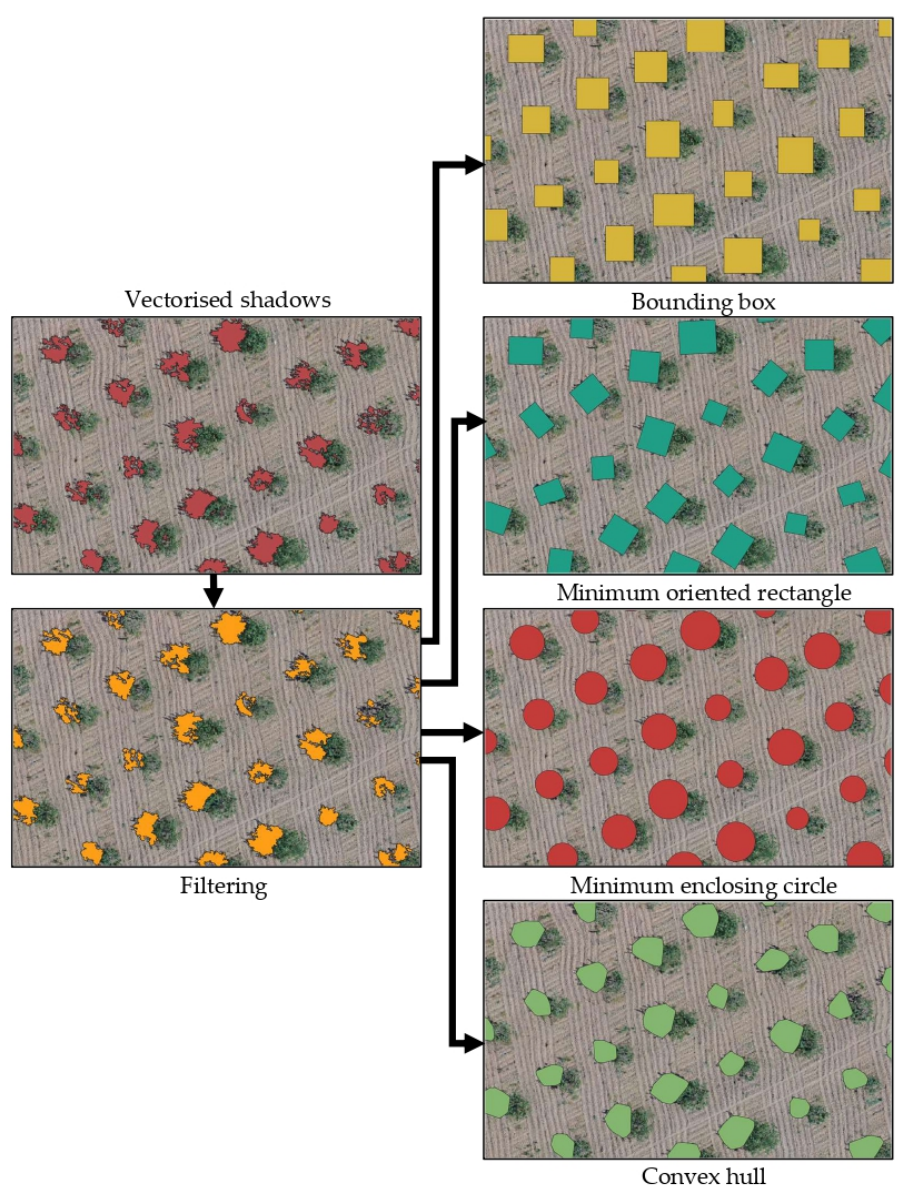
Figure 10. OBIA approach in the shadow plane. Several types of geometries were used to envelop the area detected in the images (bounding boxes, oriented rectangles, enclosing circles and convex